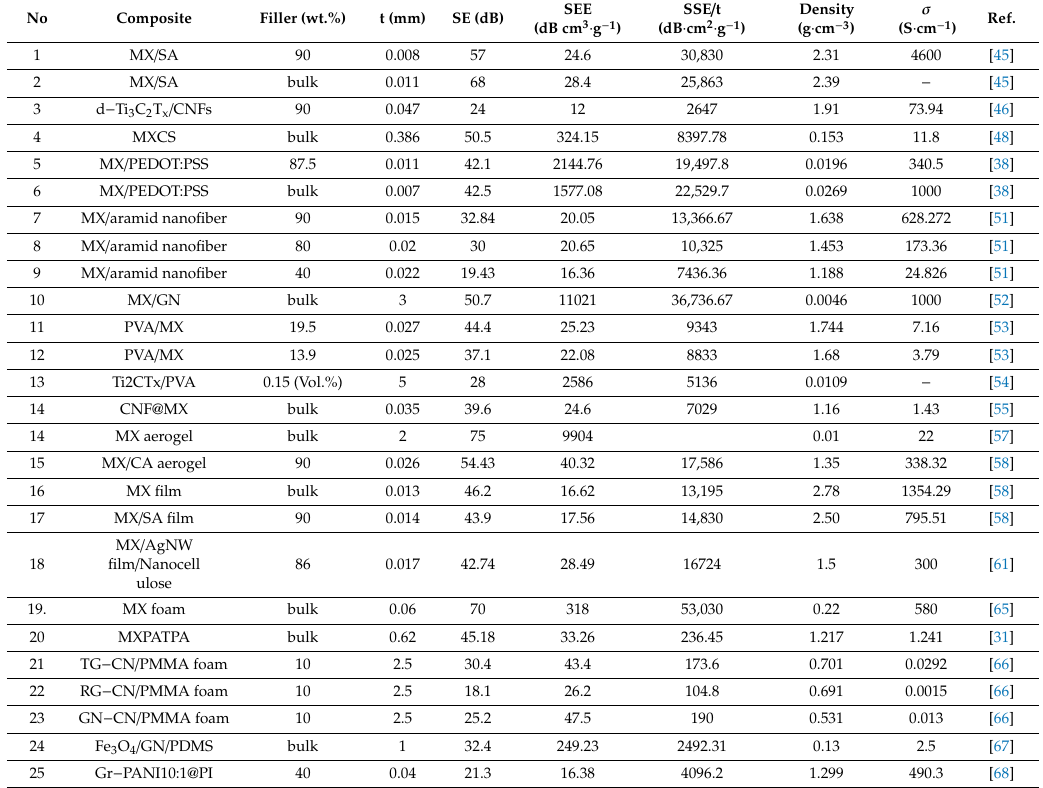
Table 3. Electromagnetic interference (EMI) shielding comparison of the two − dimension (2D) MXene (MX − Ti 3 C 2 T x ) and graphene (GN)